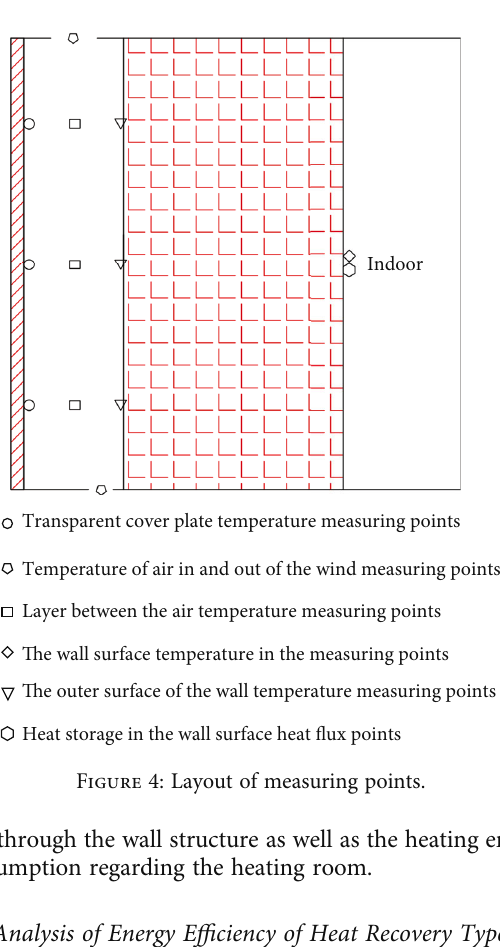
Figure 4: Layout of measuring